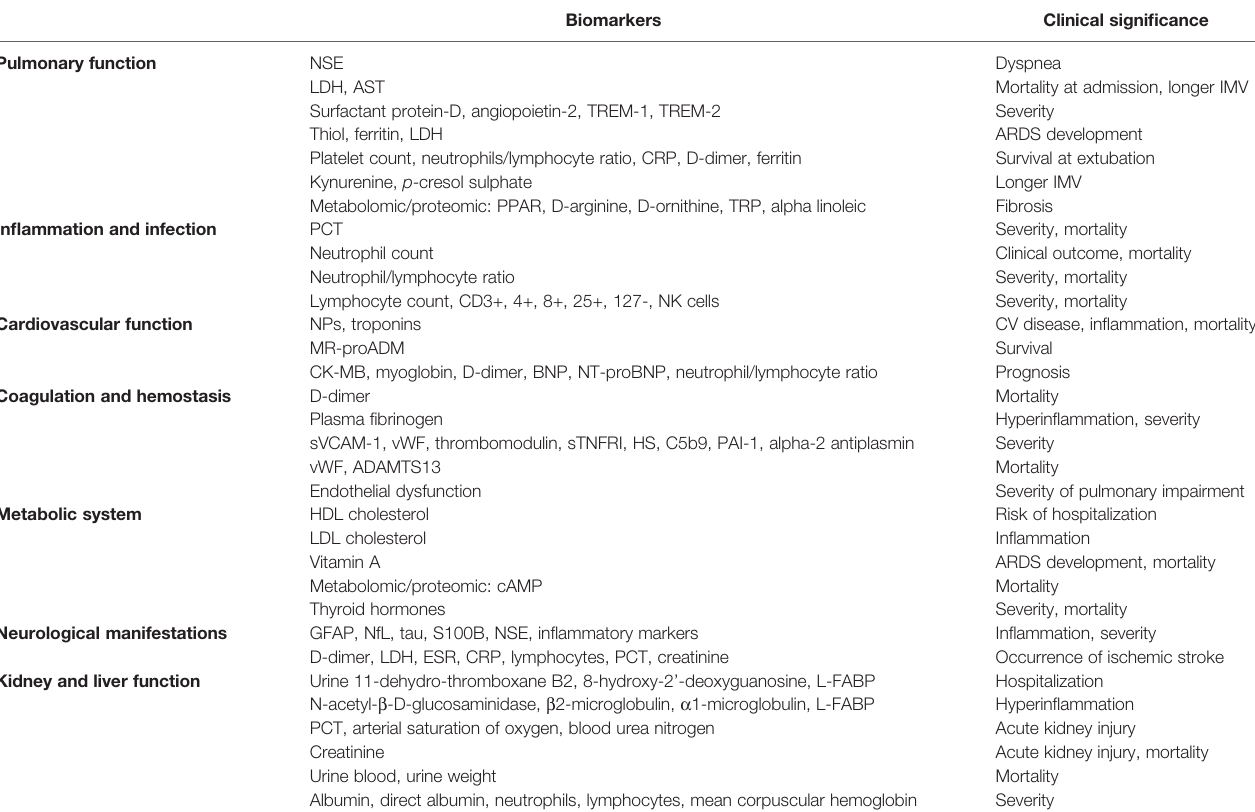
TABLE 1 | Laboratory biomarkers in COVID-19.